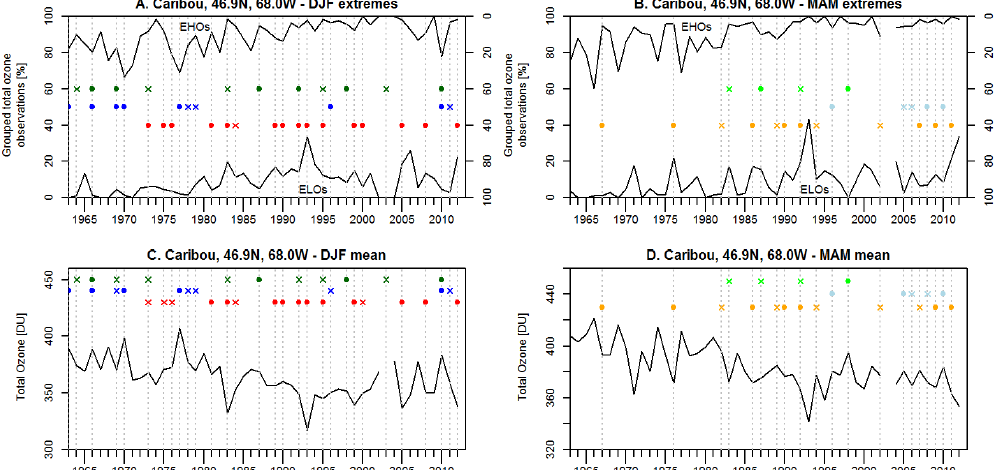
Figure 4. As Fig. 3 but for